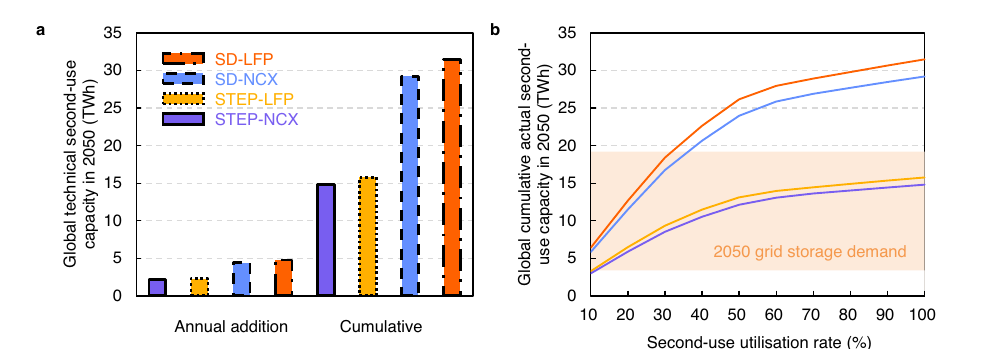
Fig. 4 | Availability of second-use capacity globally in 2050. a Average annual additions and cumulative technical capacity of second-use batteries in 2050. Here capacity refers to the technically available capacity considering battery degrada- tion but without considering battery second-use utilisation rate. b Impacts of